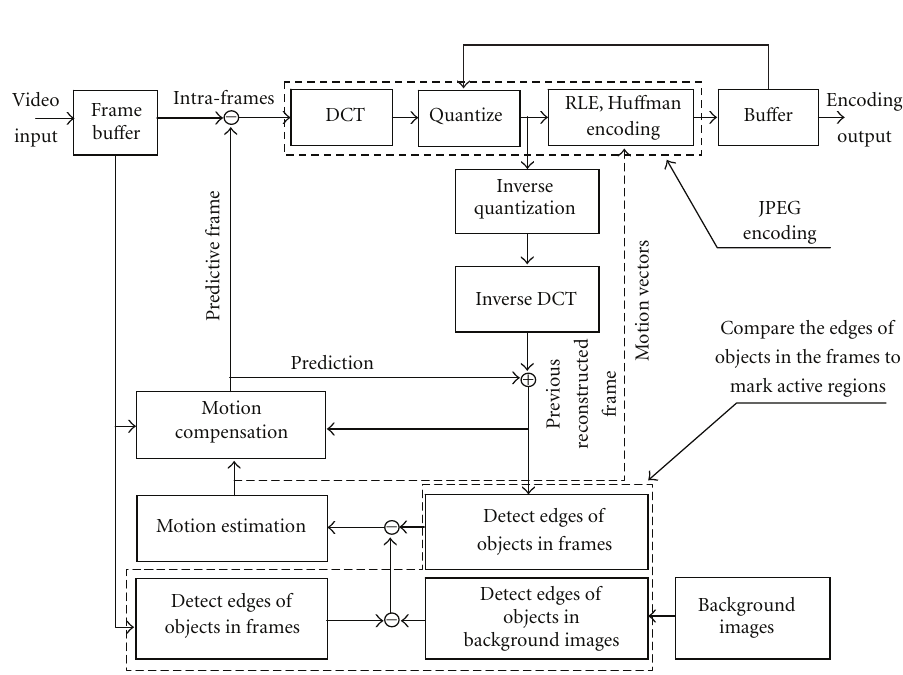
Figure 5: The details of proposed video compression algorithm based on detecting the edges of objects in the